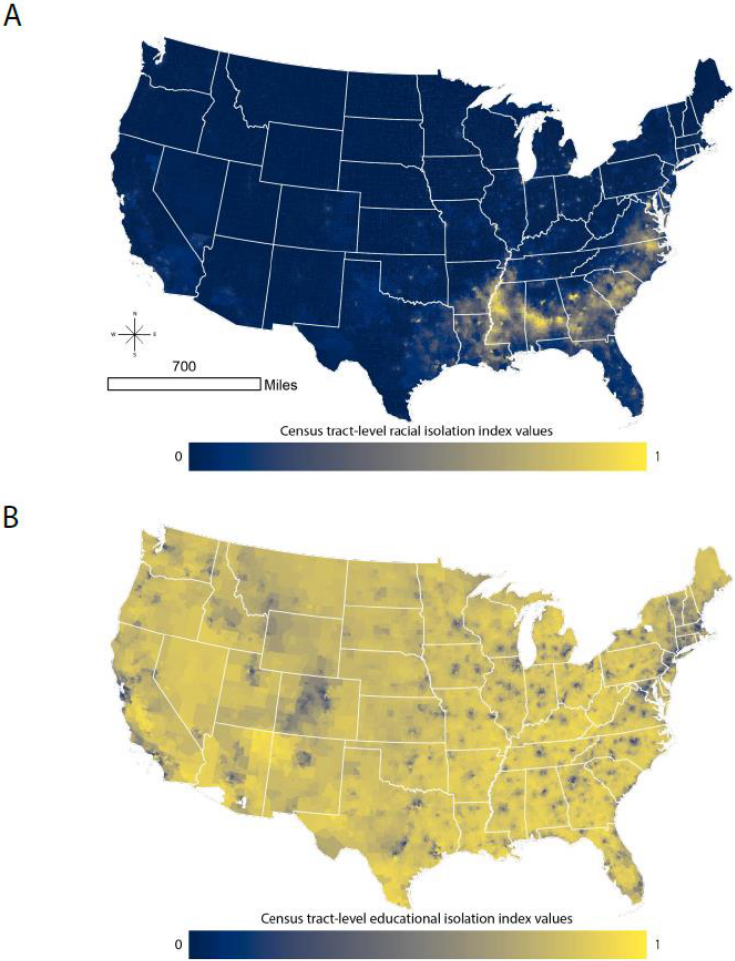
Figure 1. Census tract-level racial isolation index values (Panel A ) and educational isolation index values (Panel B ). Map projection: USA Contiguous Albers Equal Area Conic. RI ranges from 0 to 1. A value of 0 indicates that the neighborhood environment (defined as the index tract and tracts adjacent to the index tract) is entirely composed of non-NHB individuals. A value of 1 indicates that the neighborhood environment is entirely composed of NHB individuals. EI also ranges from 0 to 1. A value of 0 indicates that the neighborhood environment is entirely composed of individuals with a four-year college degree. A value of 1 indicates that the neighborhood environment is entirely composed of non-college educated individuals.